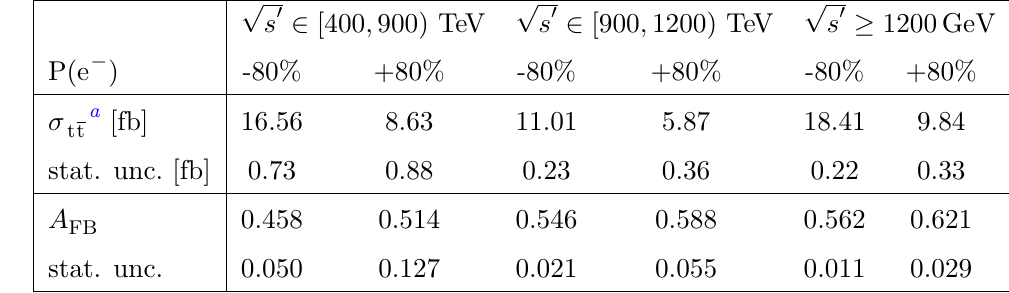
Table 11. Results from the analysis of semi-leptonically decaying top quarks at the three stages of CLIC. The values are obtained from full simulation studies using the CLIC ILD detector concept. p s 0 (cid:21) 1 : 2 (2 : 6) TeV Note that the cross section, (cid:27) , and A are de(cid:12)ned in the kinematic region of FB tt p p for operation at s = 1 : 4 TeV (3 TeV). For operation at s = 380 GeV the A for P (e (cid:0) ) = -80% FB p is extracted using the event sample de(cid:12)ned by D 2 < 1; the other results at s = 380 GeV are obtained using the sample with a looser selection cut, D 2 < 15.